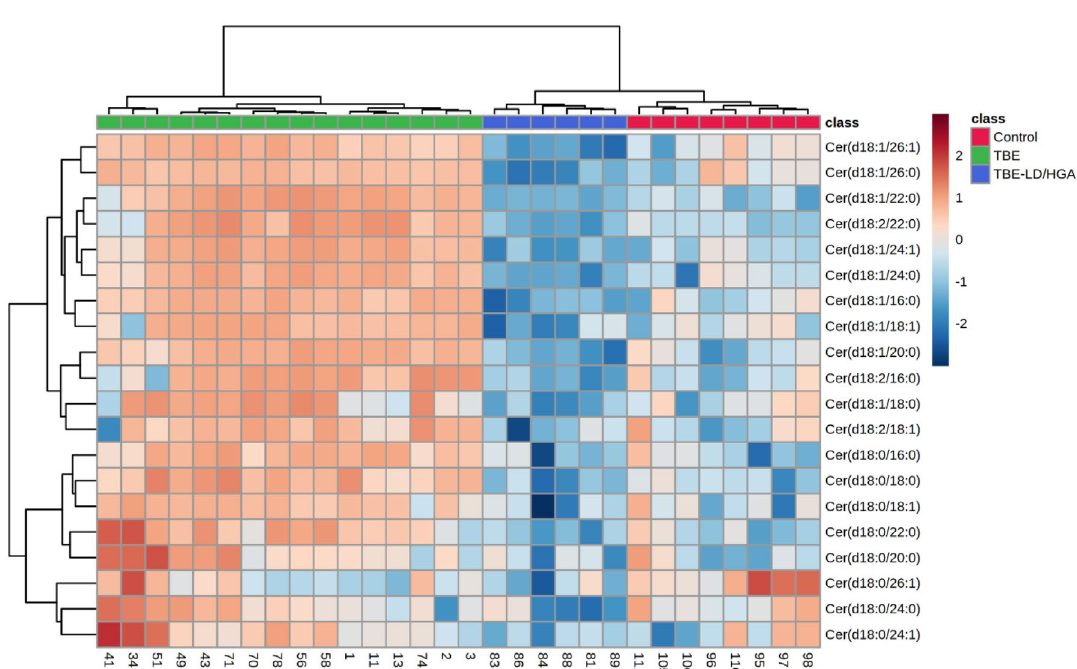
Figure 5. Two-dimensional hierarchical clustering heat map of the 20 most discriminating ceramide species (according to One-way ANOVA) identified in the plasma of healthy subjects (Control) and TBE patients (TBE) and TBE patients co-infected with LD (TBE +